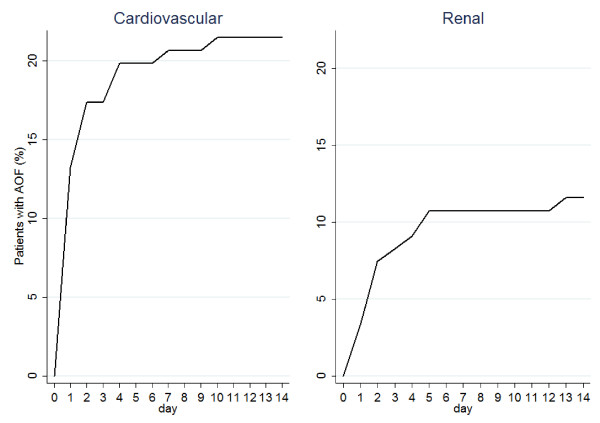
Cumulative incidence of the first episode of cardiovascular and renal failure. Day 0 is the day of screening and Day 1 the first day of follow-up. Median time (in days) to acute organ failure is: cardiovascular (1.0), renal (2.0).